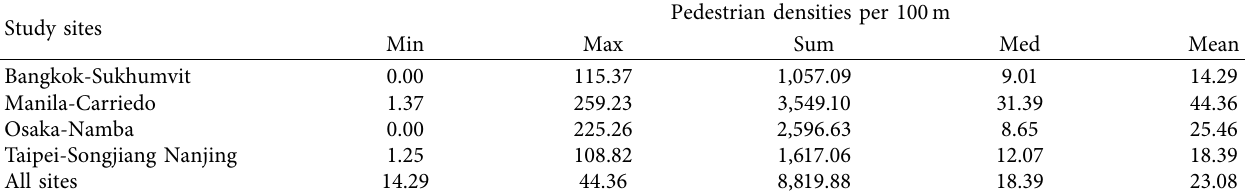
Table 2: Pedestrian density descriptive